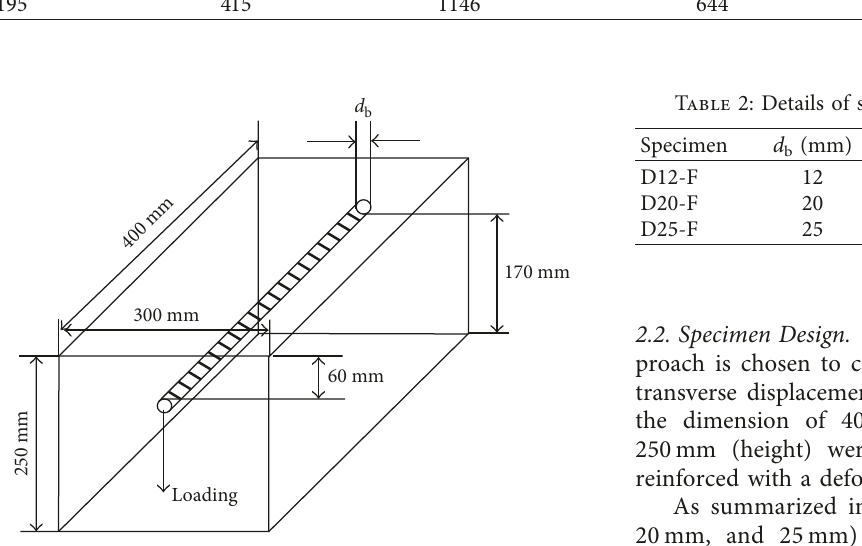
Figure 1: Dimensions of specimen.